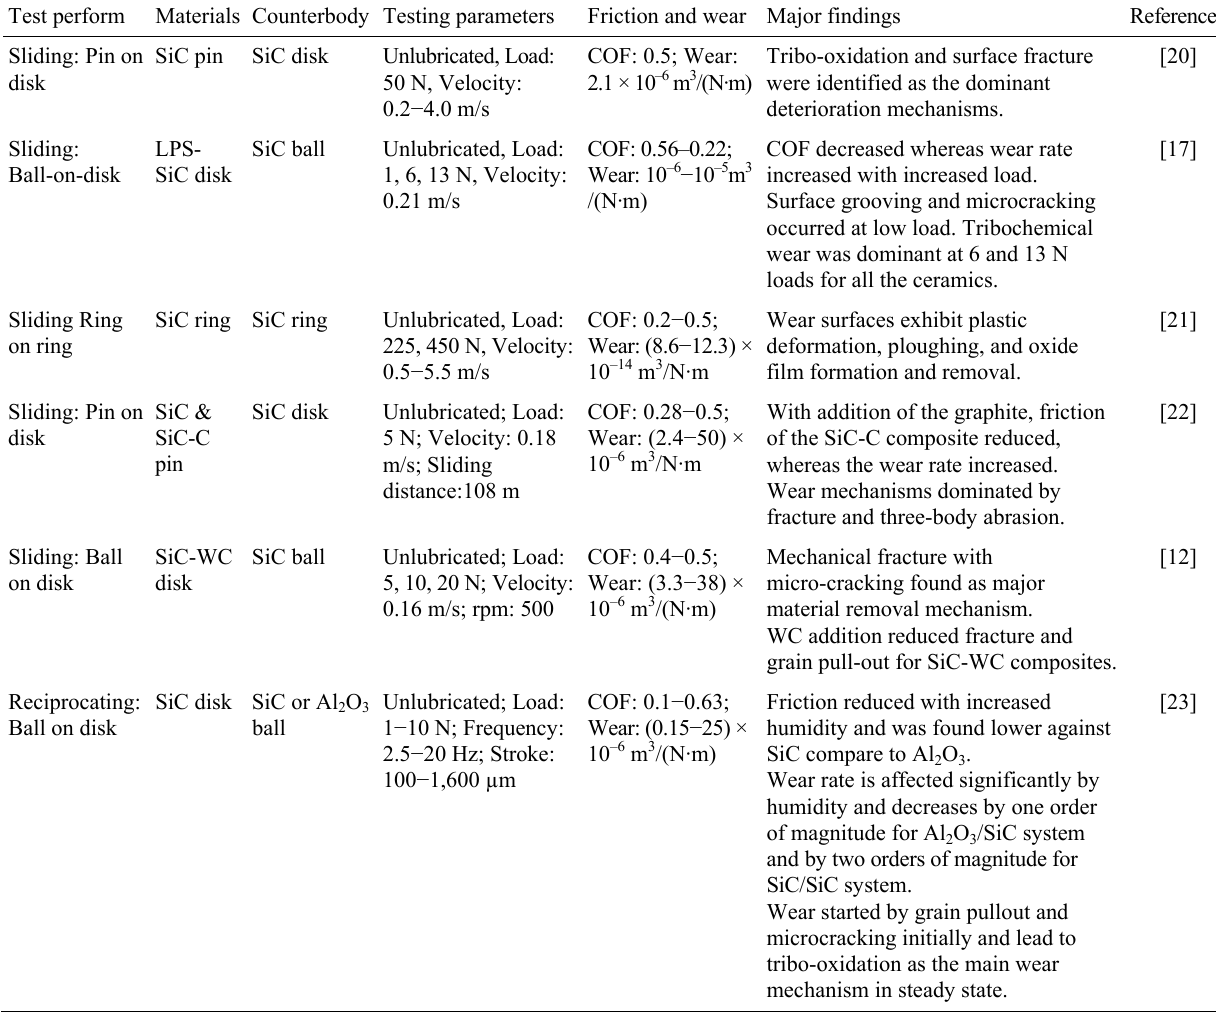
Table 1 Summary of sliding wear results of SiC based ceramics against different counterbodies. Test perform Materials Counterbody Testing parameters